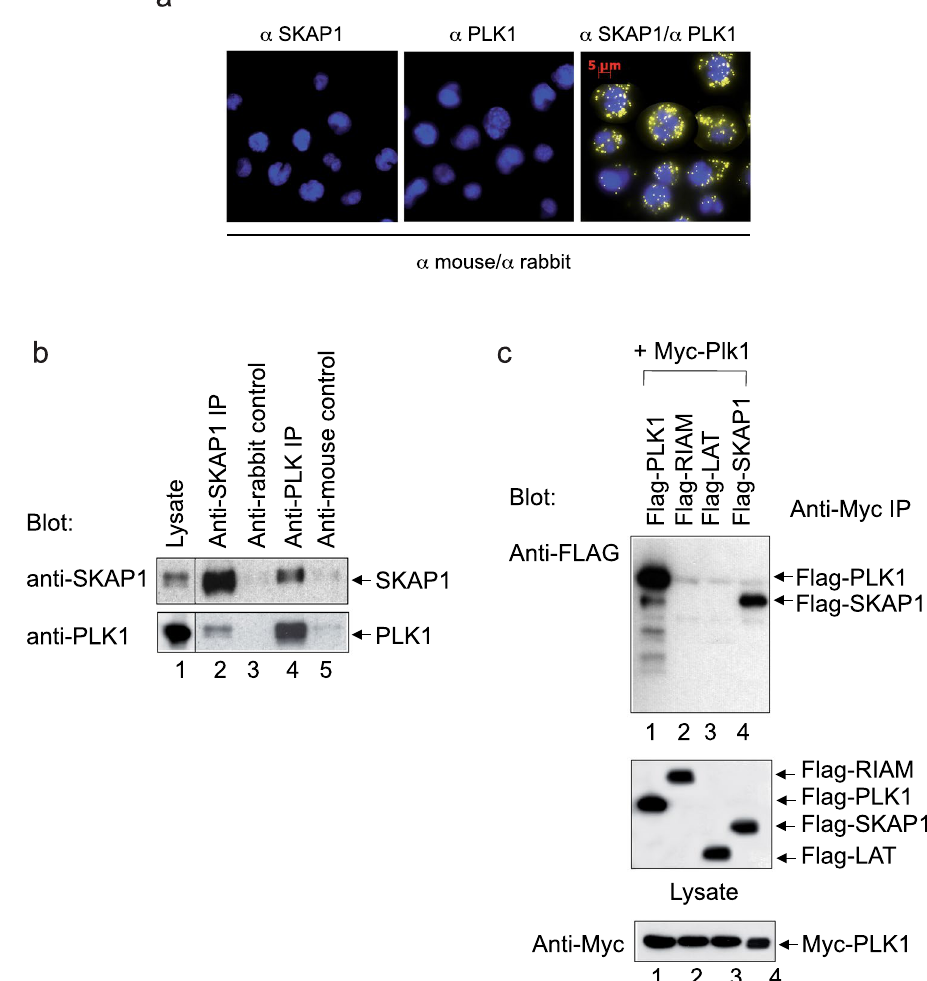
Figure 3. PLK1 binds to SKAP1. (Panel a) Proximity ligation assay (PLA) of endogenous PLK1 and SKAP1 in Jurkat T-cells shows a positive signal. (Panel b) Anti-PLK1 co-precipitates SKAP1 and vice versa. Lane 1: lysate; lane 2: anti-SKAP1; lane 3: anti-rabbit control; lane 4: anti-PLK1; lane 5: anti-mouse control. (Panel c) Anti- PLK1 co-precipitates SKAP1 from transfected Hela cells. Hela cells were transfected with either PLK1, RIAM, LAT or SKAP1 tagged with FLAG in combination with Myc- tagged PLK1. Anti-Myc co-precipitated SKAP1, but not the RIAM or LAT controls (lane 4 vs. 2, 3). It also co-precipitated Flag-PLK1 indicating that it can bind to itself (lane 1). Lower panels show the expression controls for various expressed